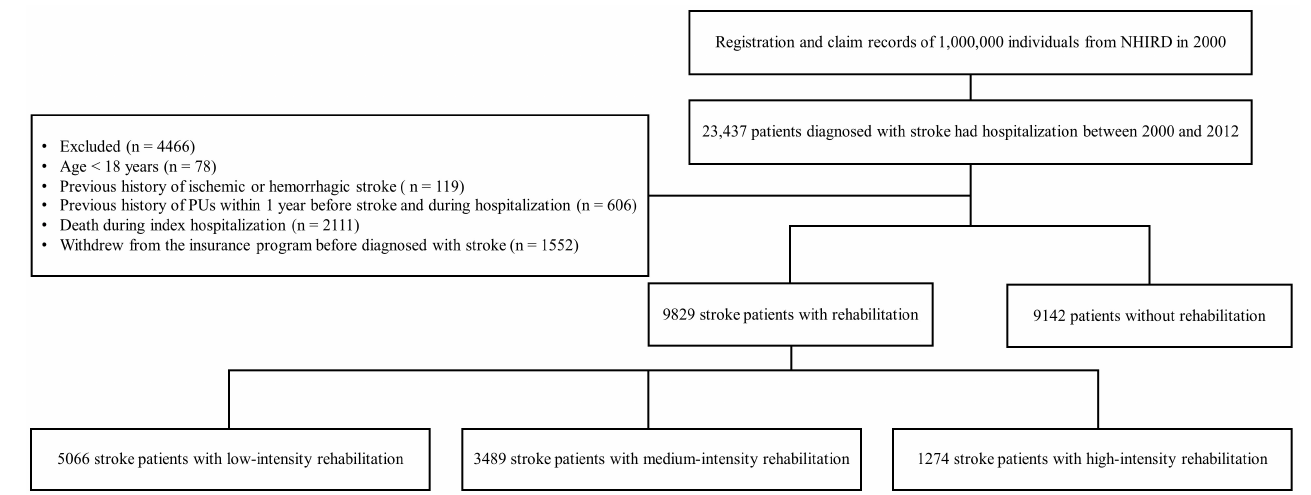
Figure 1. Flow chart illustrating the selection process of study subjects from the National Health Insurance Research Database (NHIRD) in Taiwan.